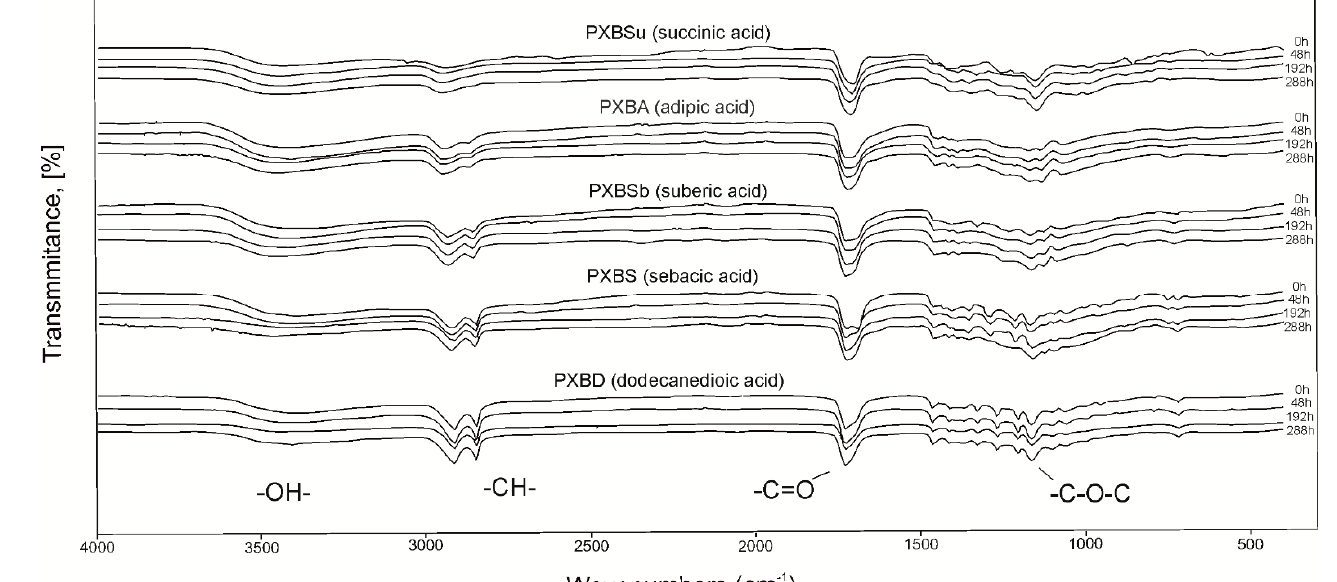
Table 2. Thermal properties of the PXBSu, PXBA, PXBSb, PXBS, PXBD.